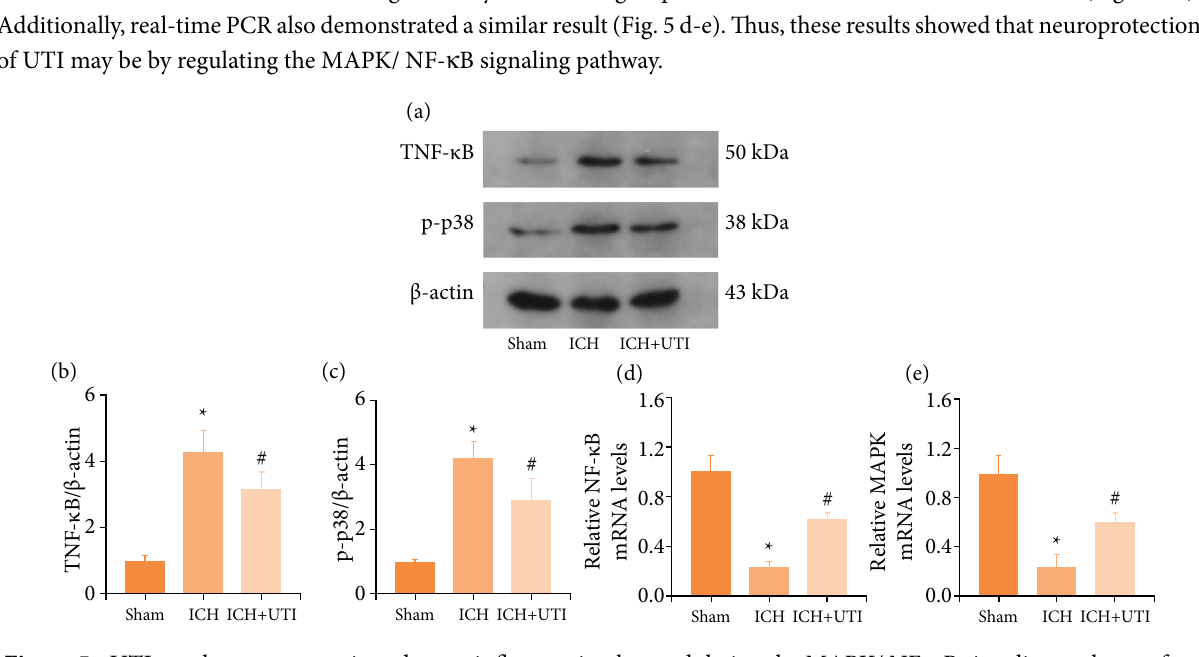
Figure 4 - UTI alleviates neuroinflammation after ICH. UTI significantly reduced hippocampal (a) TNF- α ; (b) interleukin-1 β (IL-1 β ); (c) IL-6; and (d) NF- κ B levels at 72 h after ICH (n = 5, * p < 0.05 vs. Sham; # p < 0.05 vs. ICH, ANOVA; means ± SD). UTI regulates necroptosis and neuroinflammation by modulating the MAPK/NF- κ B signaling pathway after ICH MAPK/NF- κ B was a core signaling pathway of necroptosis and neuroinflammation 43,44 . Whether the neuroprotection of UTI regulates necroptosis and neuroinflammation was explored by modulating the MAPK/NF- κ B signaling pathway after ICH. The levels of the MAPK and NF- κ B protein were detected by performing western blotting (Fig. 5a). The levels